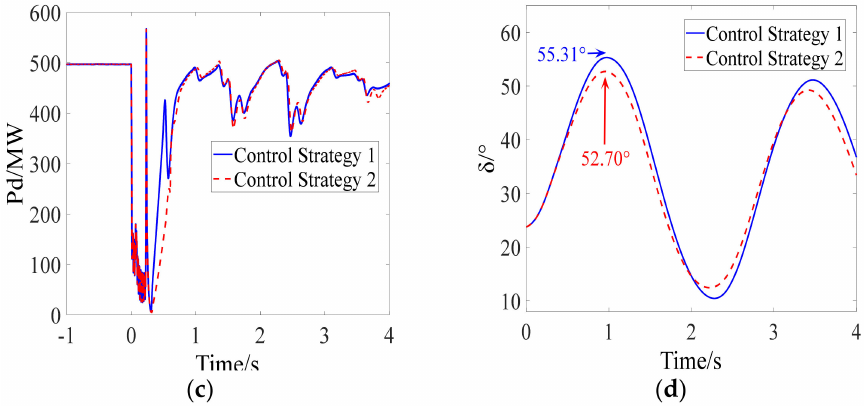
Figure 16. Simulation results of Scenario 2. ( a ) Inverter bus voltage, ( b ) extinction angle, ( c ) DC power, ( d ) relative rotor angle.